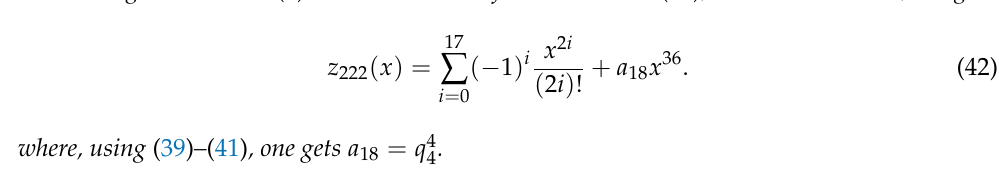
Table 1. Coefficients of y 02 , y 12 , and y 22 from (39) – (41) for computing the Taylor-based approxima- tion z 222 ( B ) of order 2 m = 34 + from (36) of the matrix